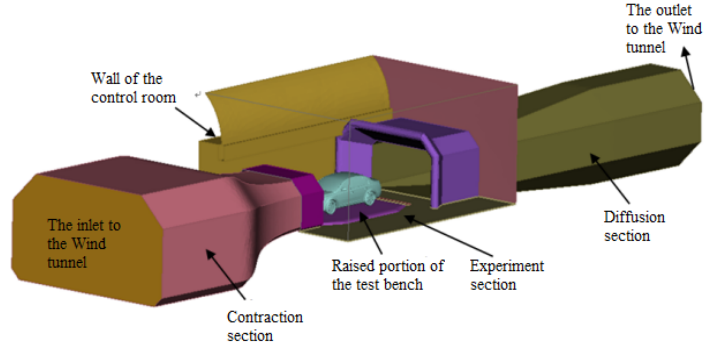
Figure 9. Computational domain.